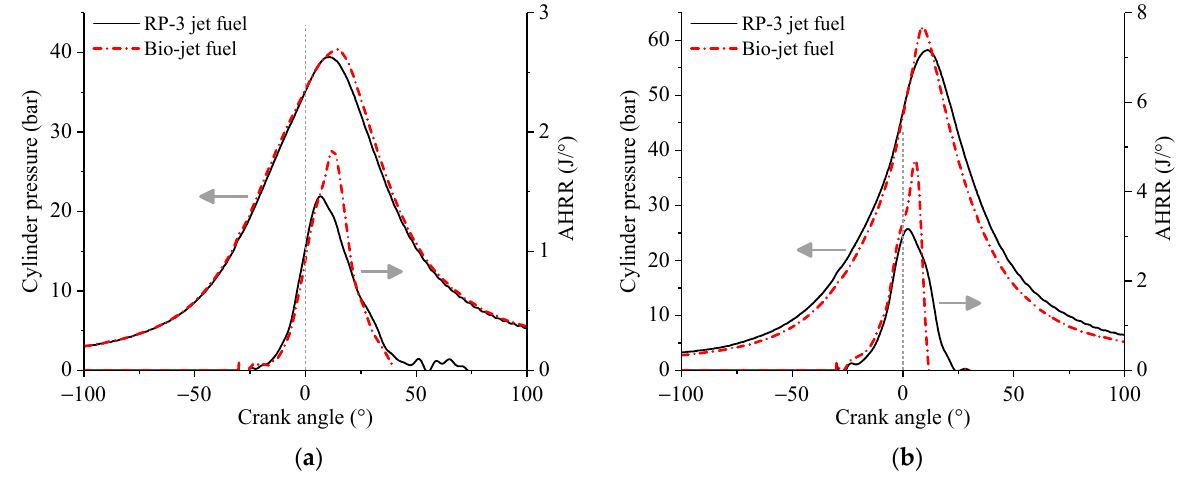
Figure 8. Variation of cylinder pressure and AHRR against crank angle at ( a ) 46% throttle opening and ( b ) 64% throttle opening.